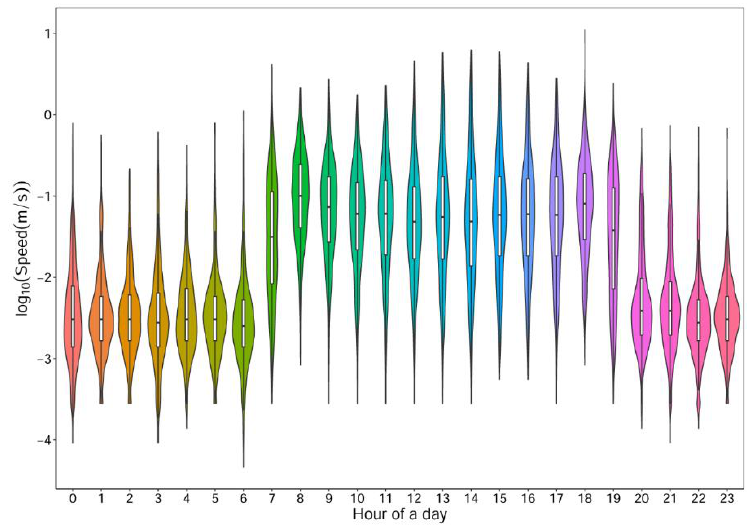
Figure 2. Hourly distribution of the travel distance over the course of a day. Landscape composition and configuration were obtained from the land cover